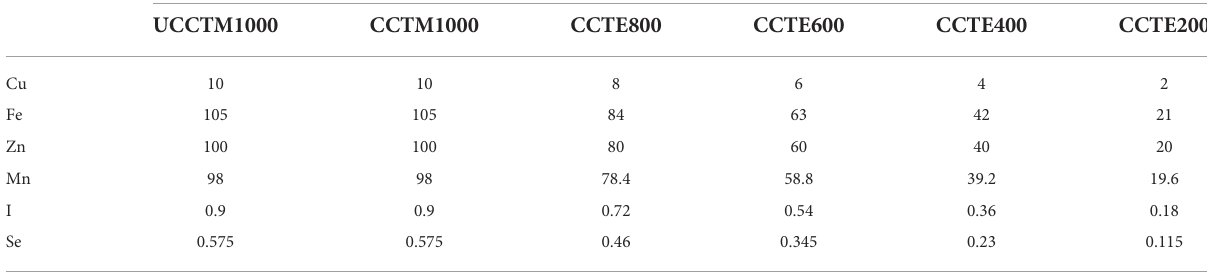
TABLE 1 Supplemental levels of trace minerals (TMs) in experimental diets